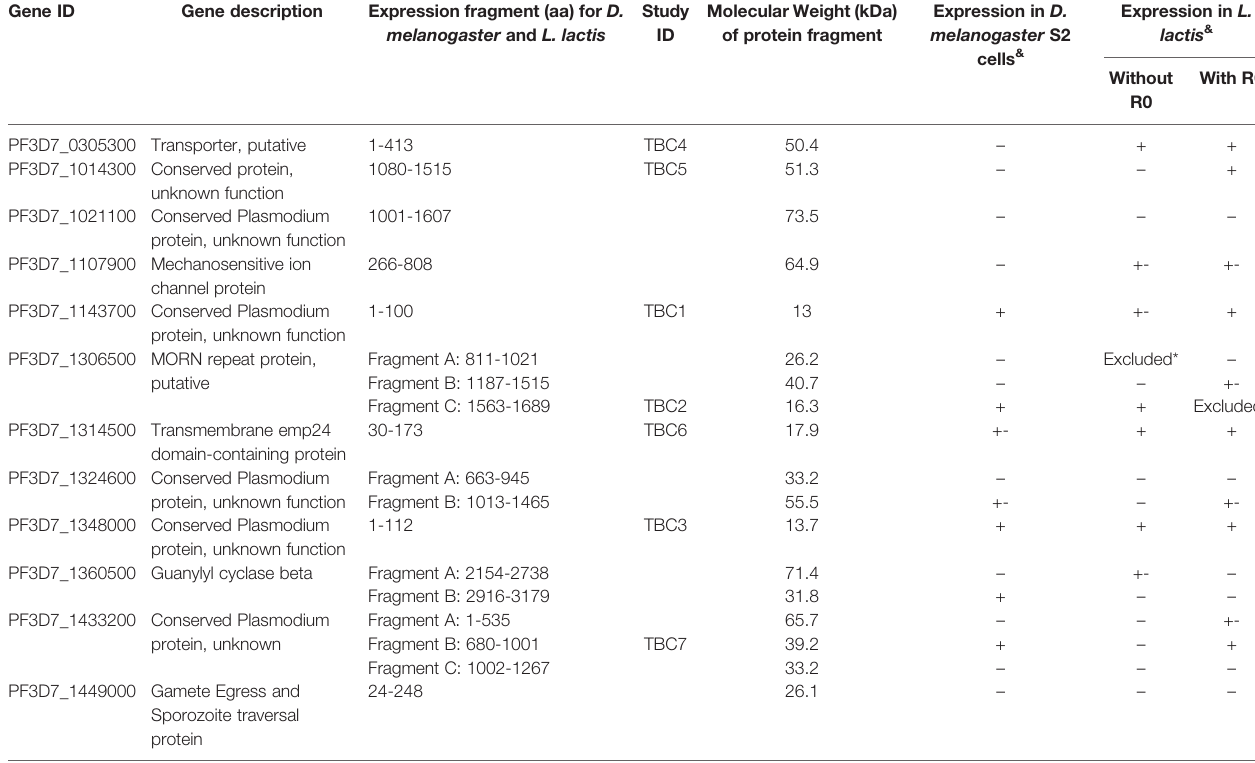
TABLE 1 | Overview of protein fragments and expression levels in Drosophila melanogaster S2 cells and Lactococcus lactis . Gene